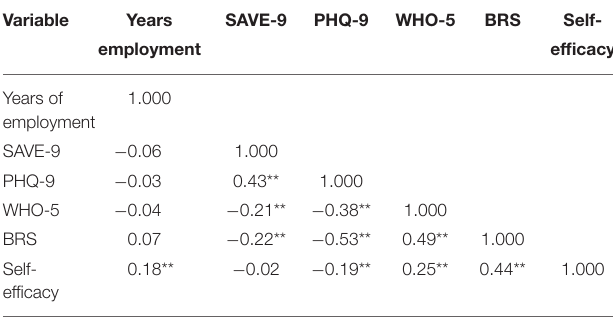
TABLE 1 | Participants’ demographic characteristics ( N = 400). TABLE 2 | Spearman’s correlation coefficients of each variable for all participants ( N = 400).